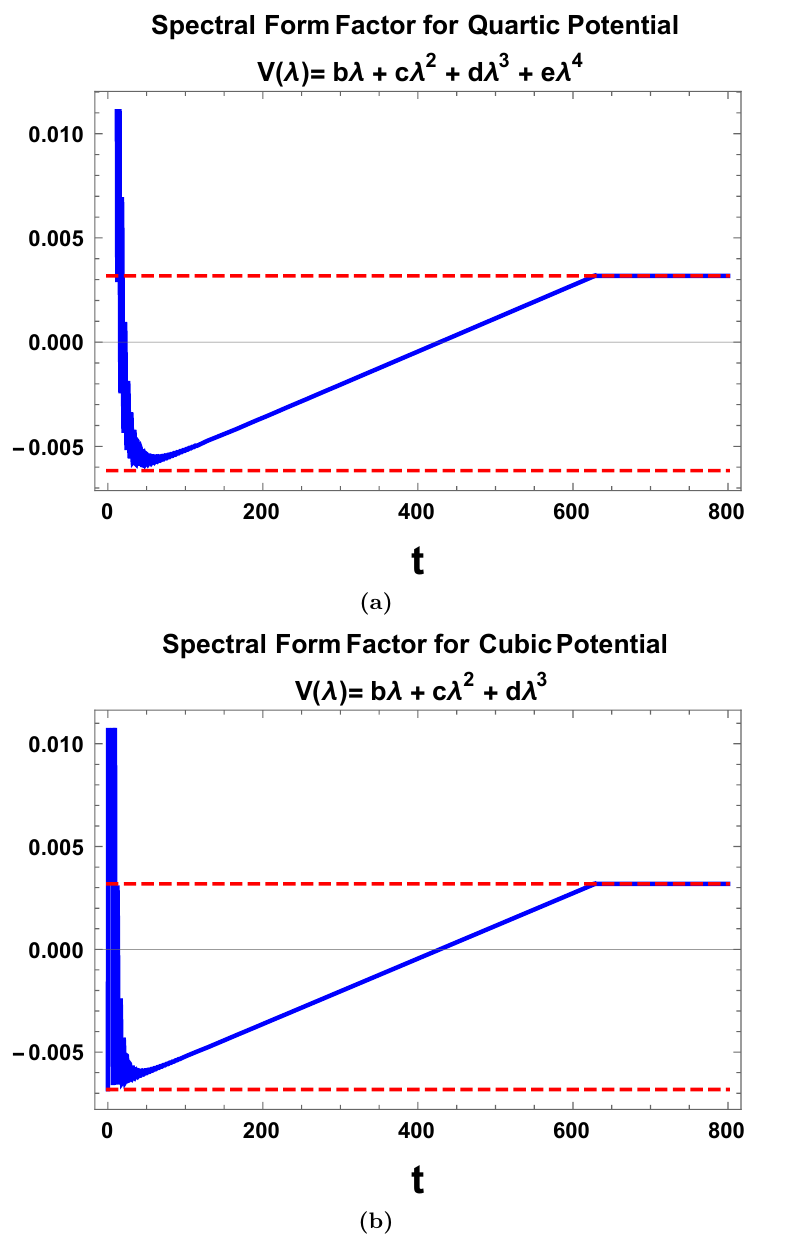
Figure 1 . Behavior of SFF at (cid:12)nite temperature for di(cid:11)erent quartic and cubic) polynomial random potentials.